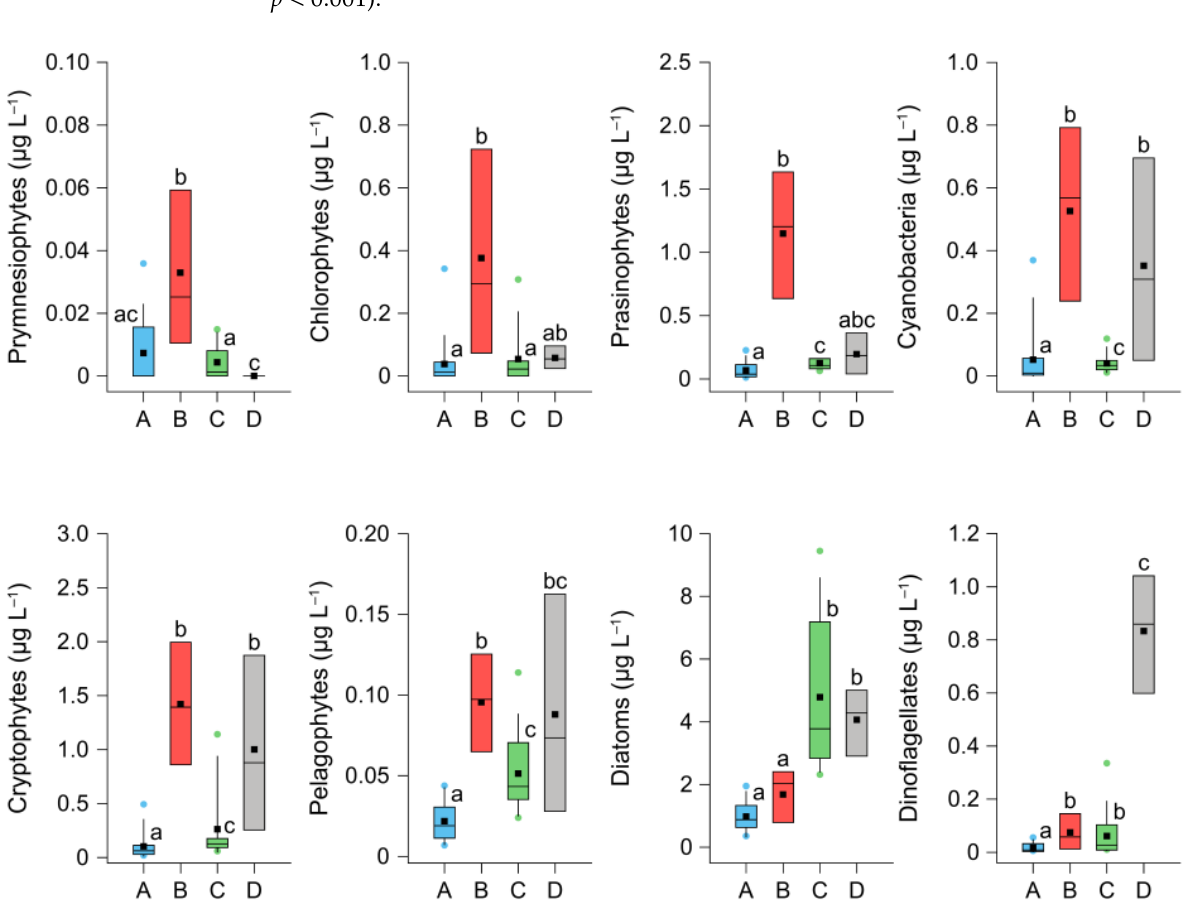
Figure 5. Concentrations of the phytoplankton groups in four SOM clusters. The horizontal line and black square inside the box indicate the median and mean values of each cluster, respectively. The significance of the difference in the concentrations among those clusters was tested using a Kruskal–Wallis test, followed by a Mann–Whitney pairwise comparison test. The same superscript indicates the absence of significant differences between medians ( p > 0.05). Table 2. Results of the indicator species analysis for the SOM